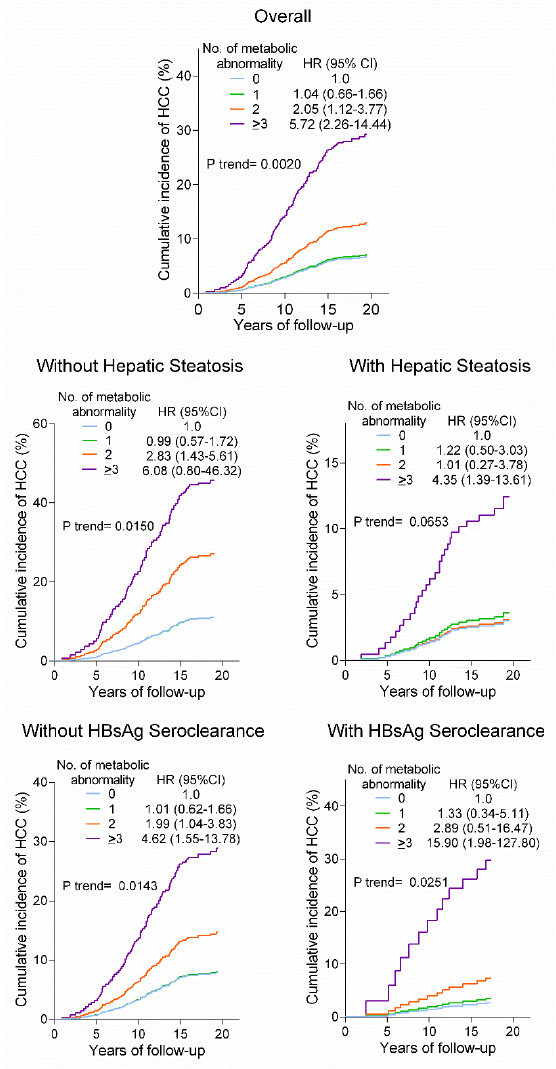
Figure 4. Absolute and relative risks of hepatocellular carcinoma (HCC) based on the number of metabolic abnormality (i.e., diabetes, obesity ( BMI ≥ 25 kg/m 2 ), high blood pressure, and hypertriglyceridemia). The cumulative incidence function and HRs (95% CIs) were derived from Cox models adjusted for age, hepatic steatosis, HBsAg seroclearance or not, genetic polymorphisms of PNPLA3, TM6SF2, and MBOAT7, and tobacco and alcohol use.